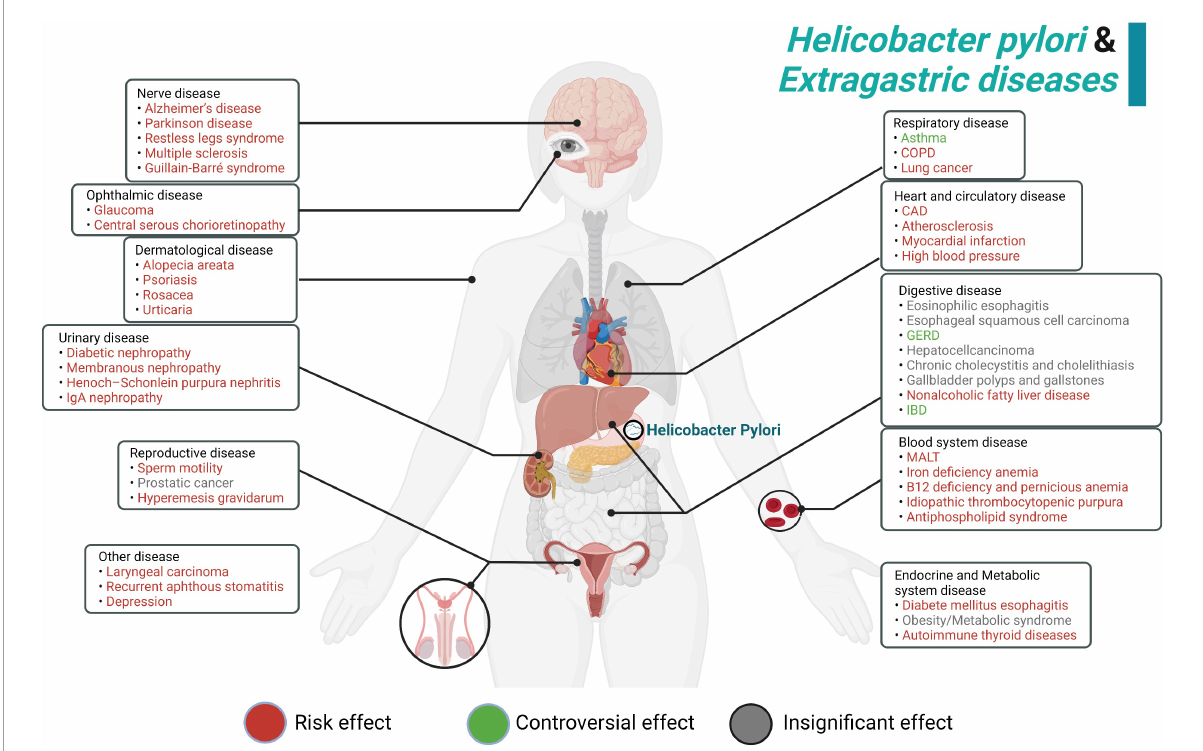
FIGURE2 Summary schematic of the systematic effect of H. pylori infection. In red, the manifestations for which H. pylori infection represents a risk effect. In green, although some studies revealed that H. pylori showed a positive effect on these diseases, there are still many controversial aspects and further research is needed. In gray, we show the manifestations for which H. pylori infection shows an insignificant